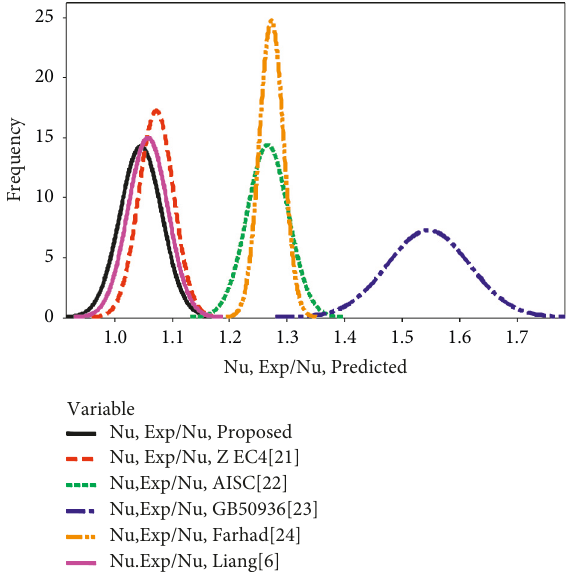
Figure 9: Validation of test results with various International codes and model proposed in-Histogram